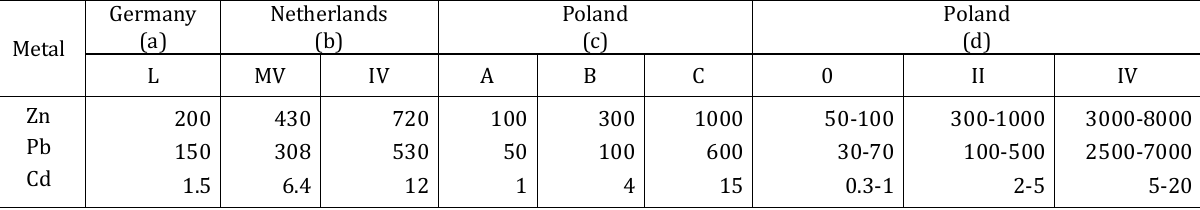
Table 3. Acceptable values of Zn, Pb i Cd [mg kg -1 ] in soil (Cabała, 2009)